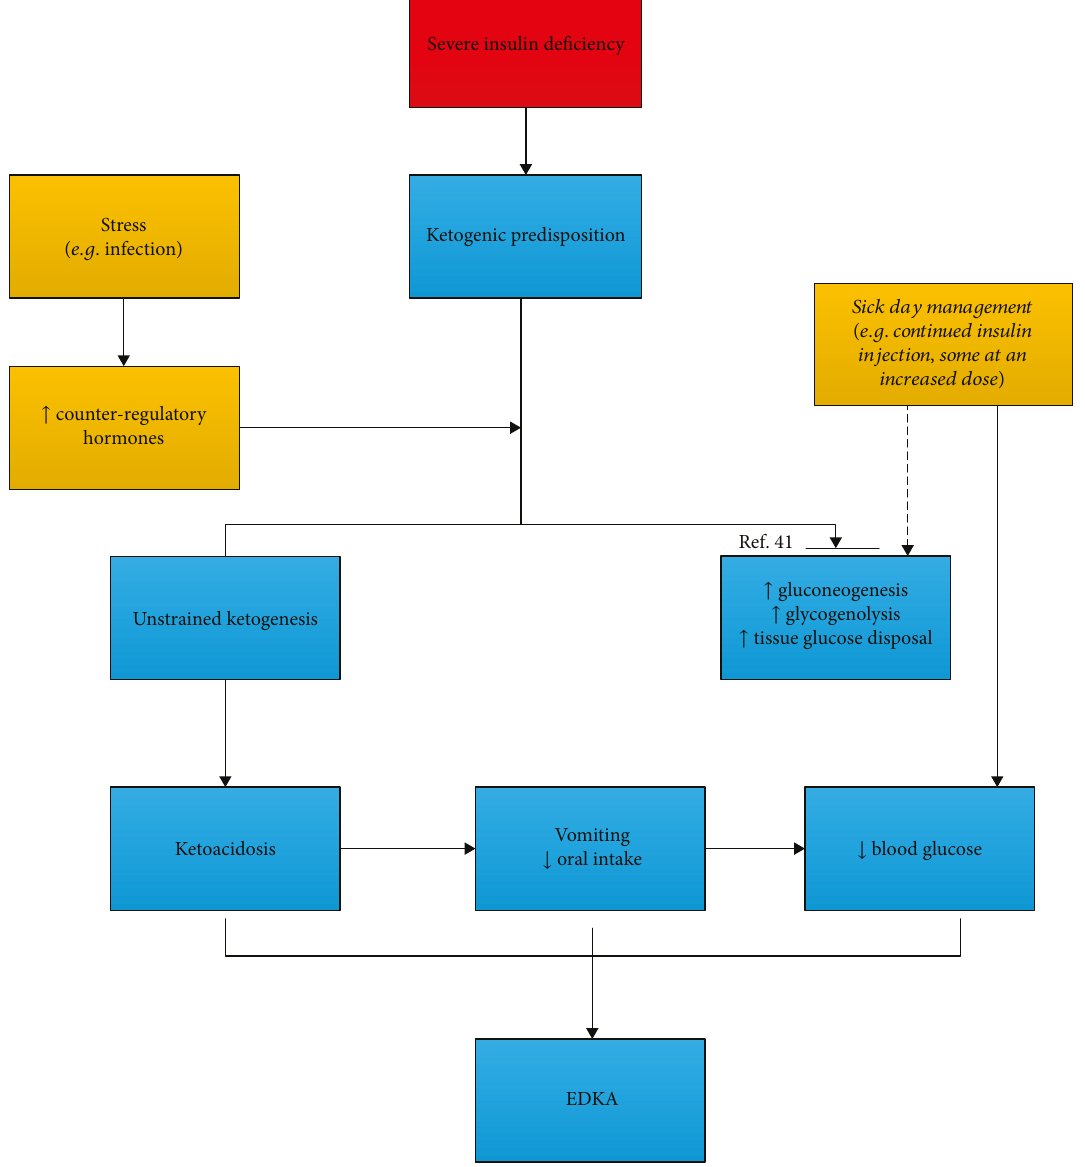
Figure 4: EDKA in an insulin-dependent setting: the hormonal contribution may di ff er from a non-insulin-dependent setting. With glucagon devoting primarily to ketogenesis (rather than to hyperglycemia) and the remedial insulin treatment, DKA supervenes with a lower blood